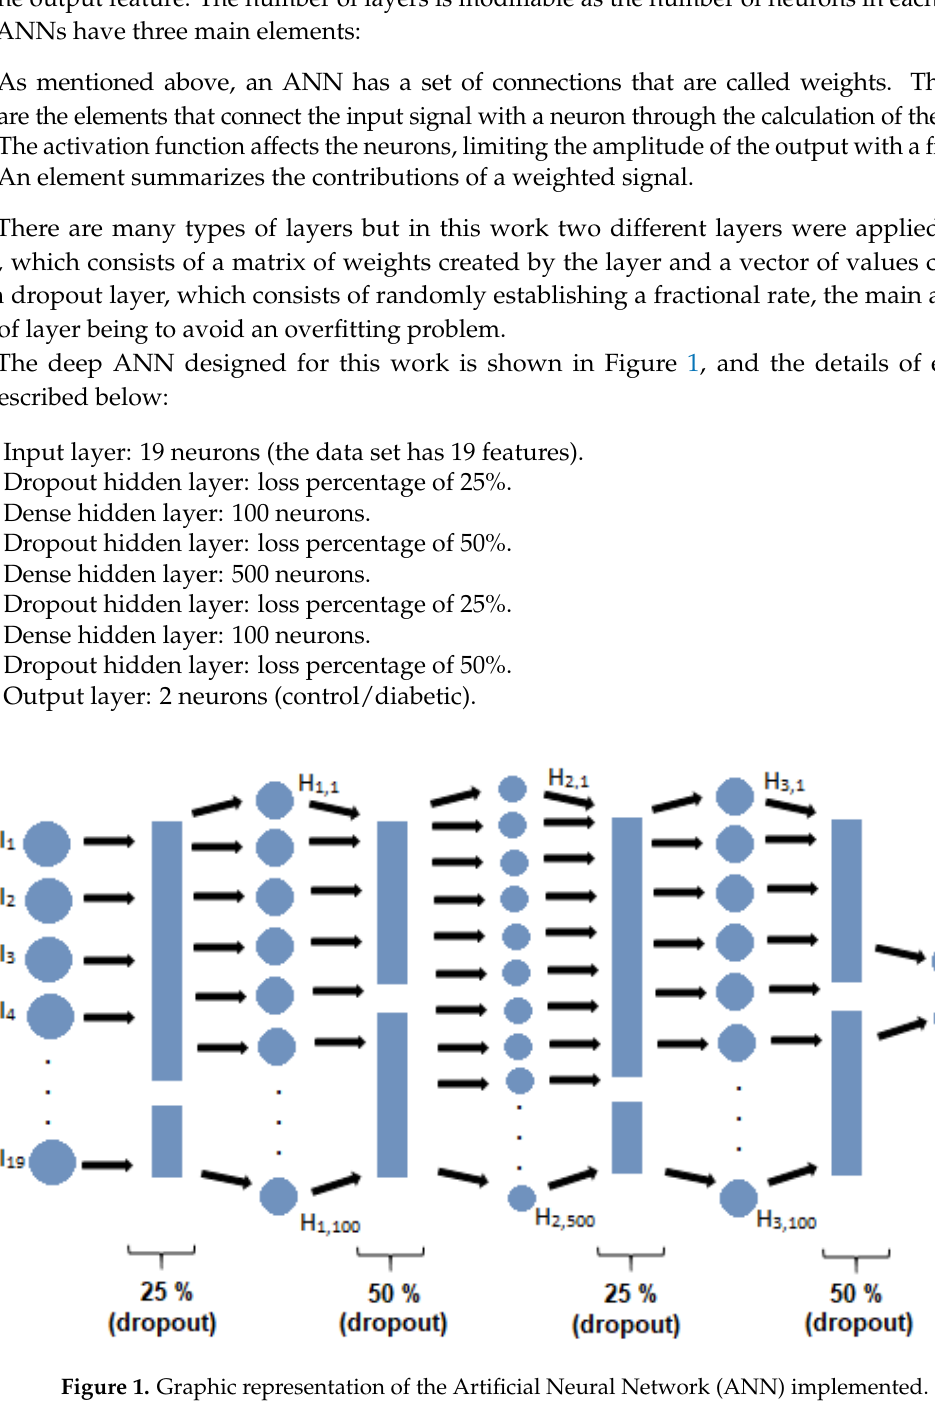
Figure 1. Graphic representation of the Artificial Neural Network (ANN)